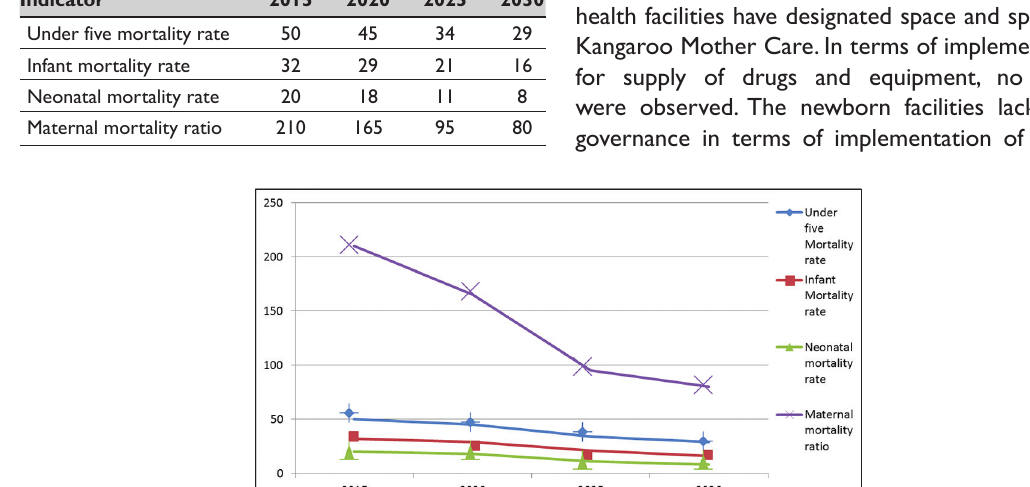
Table 6: Projections in key mortality rates using LiST